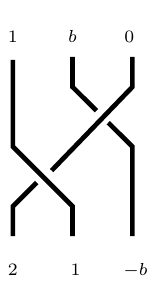
Fig. 7: Propagation of colors down σ 2 σ − 1